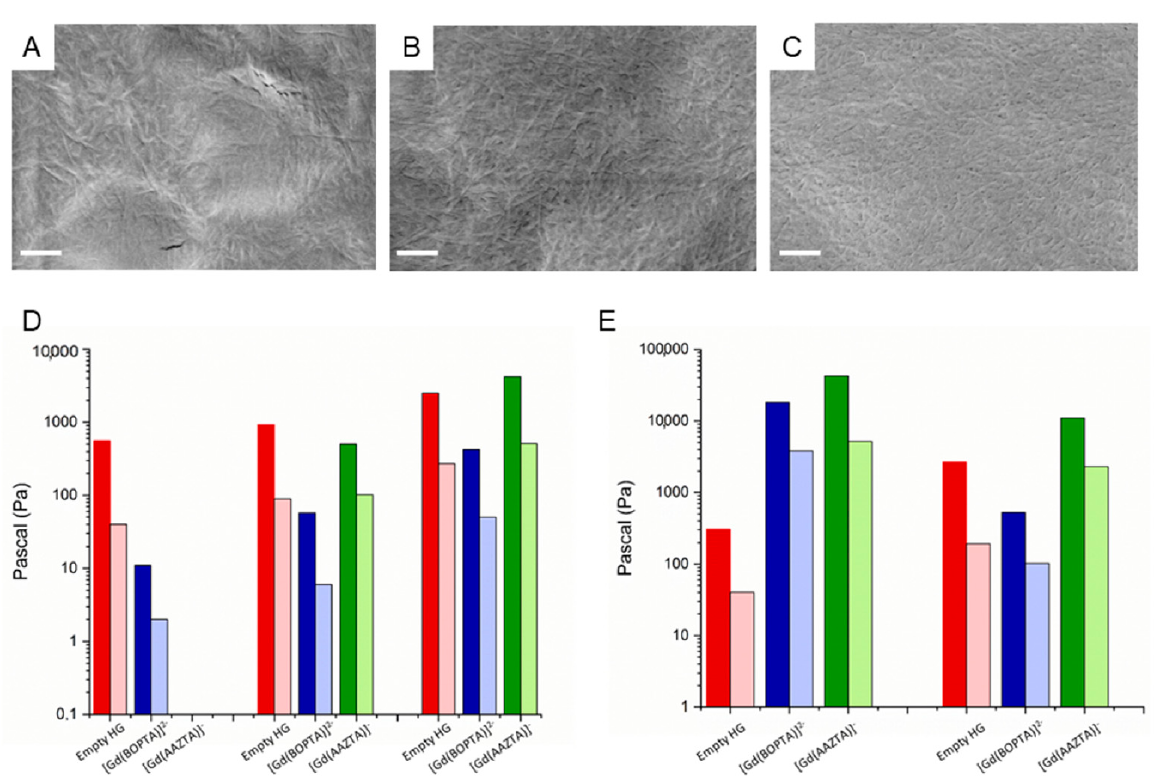
Figure 2. Structural characterization of hydrogels filled with Gd complexes. SEM micro-photos of Fmoc-K1 ( A ), Fmoc-K2 ( B ), and Fmoc-K3 ( C ) loaded with [Gd(BOPTA)] 2 − (scale bar is 500 nm). Rheological histogram analysis performed on hydrogels loaded with Gd complexes. ( D ) Fmoc-peptides; ( E ) Ac-peptides. Graph report both G ′ (dark bar) and G ″ (light bar) moduli of each time sweep experiment (20 min, strain of 0.1%, frequency 1 Hz). Values are expressed as a Pascal (Pa) logarithmic scale. Time sweep measurements are not in triplicate.